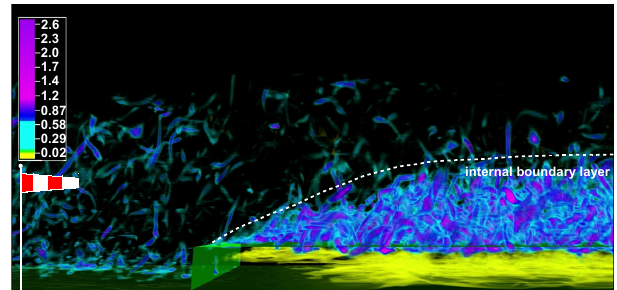
Figure 9. Snapshot of the absolute value of the 3-D rotation vec- tor of the velocity field above a forest canopy downstream of a grassland-to-forest transition (forest volume marked by green iso- surface). Pink and yellow colors illustrate strong and weak turbu- lence, respectively. A neutrally stratified open-channel flow was simulated with the mean flow direction from left to right, i.e., per- pendicular to the windward forest edge, using an equidistant grid spacing of 3m. The figure shows only a subregion of the simulation domain (2 × 1 × 0 . 4 km 3